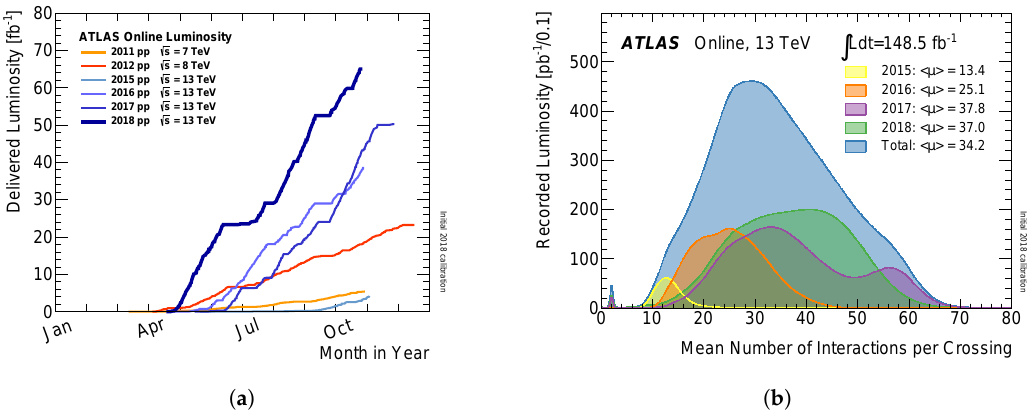
Figure 1. ( a ) Cumulative luminosity versus day for 2011-2018 delivered to ATLAS during stable beams for high energy p-p collisions [3]. ( b ) Mean number of Interactions per Crossing, showing the 13 TeV data from 2015–2018